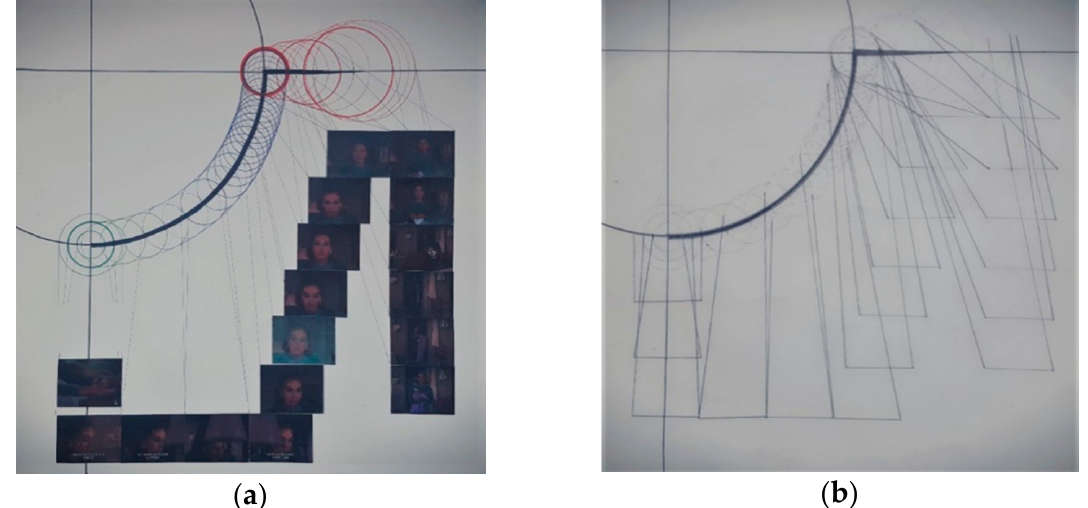
Figure 4. An example of a student’s work: ( a ) representing filmic space and ( b ) extracting architectural elements from the conceptual sketch.